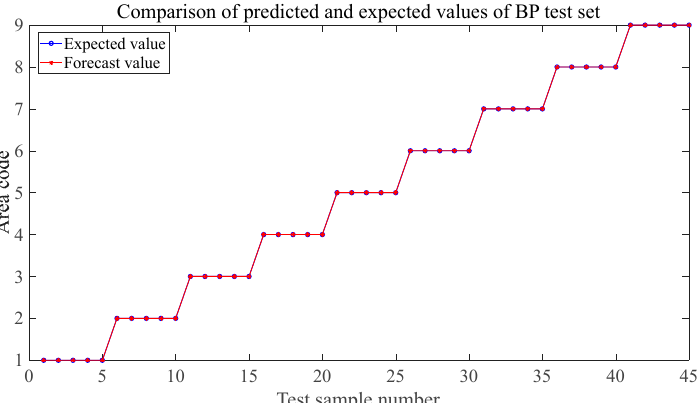
Figure 13. Prediction results when the excitation point of the test set is within 20 mm of the center.